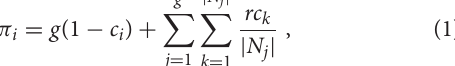
1 links are space-dependent with probability α and